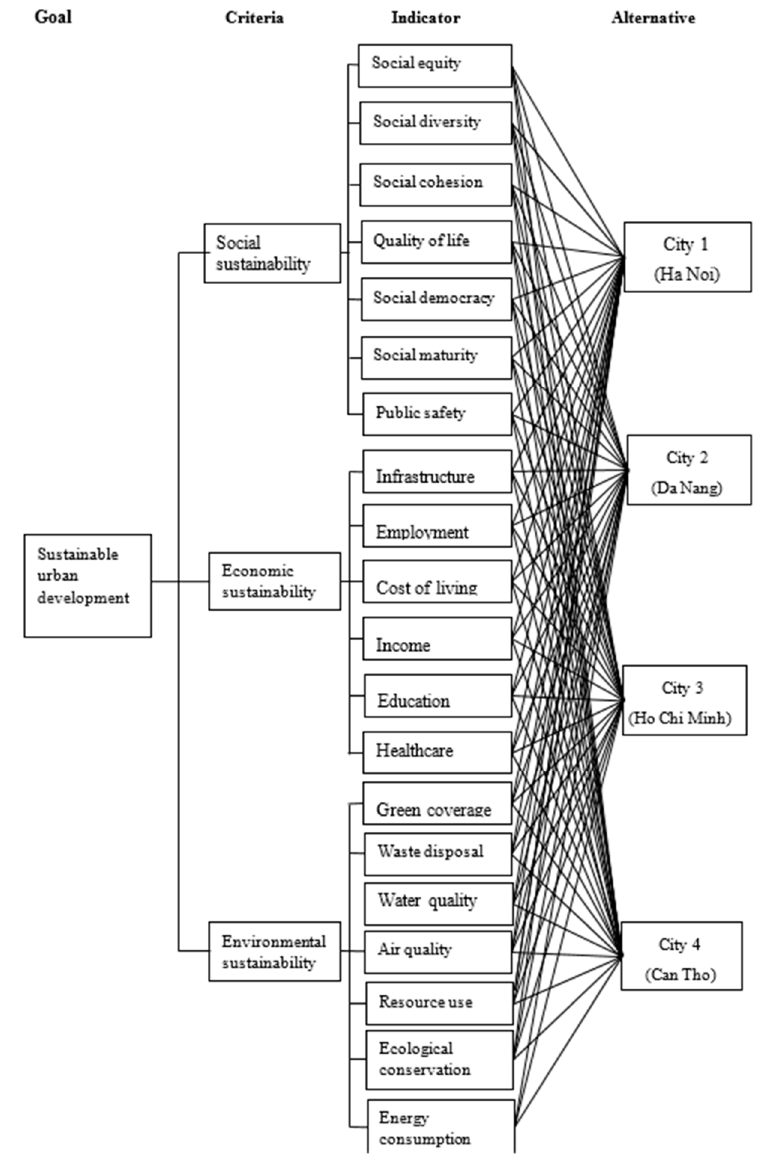
Figure 1. Criteria of sustainable urban development. Table 2. Descriptive statistics of major cities in Vietnam (2018).